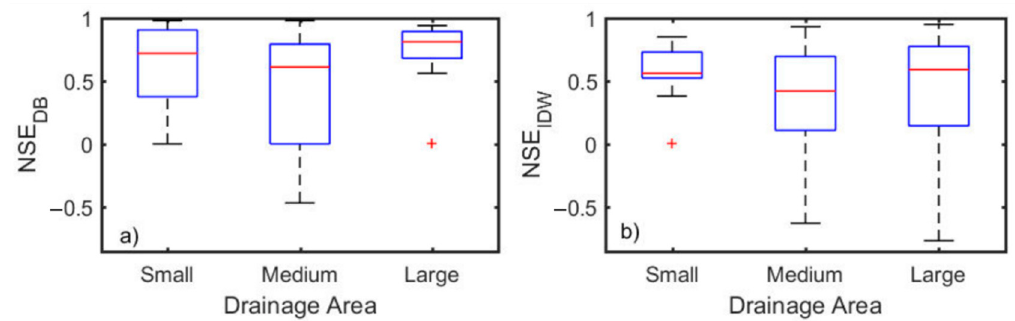
Figure 8. Plots showing NSE box plots for the three groups of basins: small, medium and large. NSE box plots for the DB model ( a ) and the IDW model ( b ). The study basins are sorted into groups according to their drainage area, and each group has nearly the same number of basins. Note that basins with NSE less than − 1 are not included in the plots as they are likely associated with significant observational errors. Although the patterns are not very clear, the two plots seem to offer some contrasting perspectives: the DB model’s performance improves with basin size, whereas the IDW model’s performance declines with drainage area.